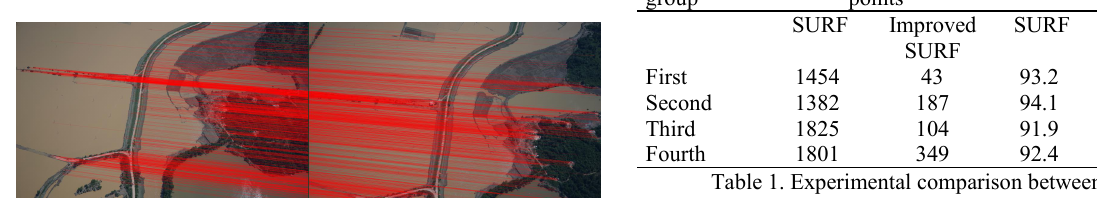
Figure 5. Matching feature points based-on SURF algorithm